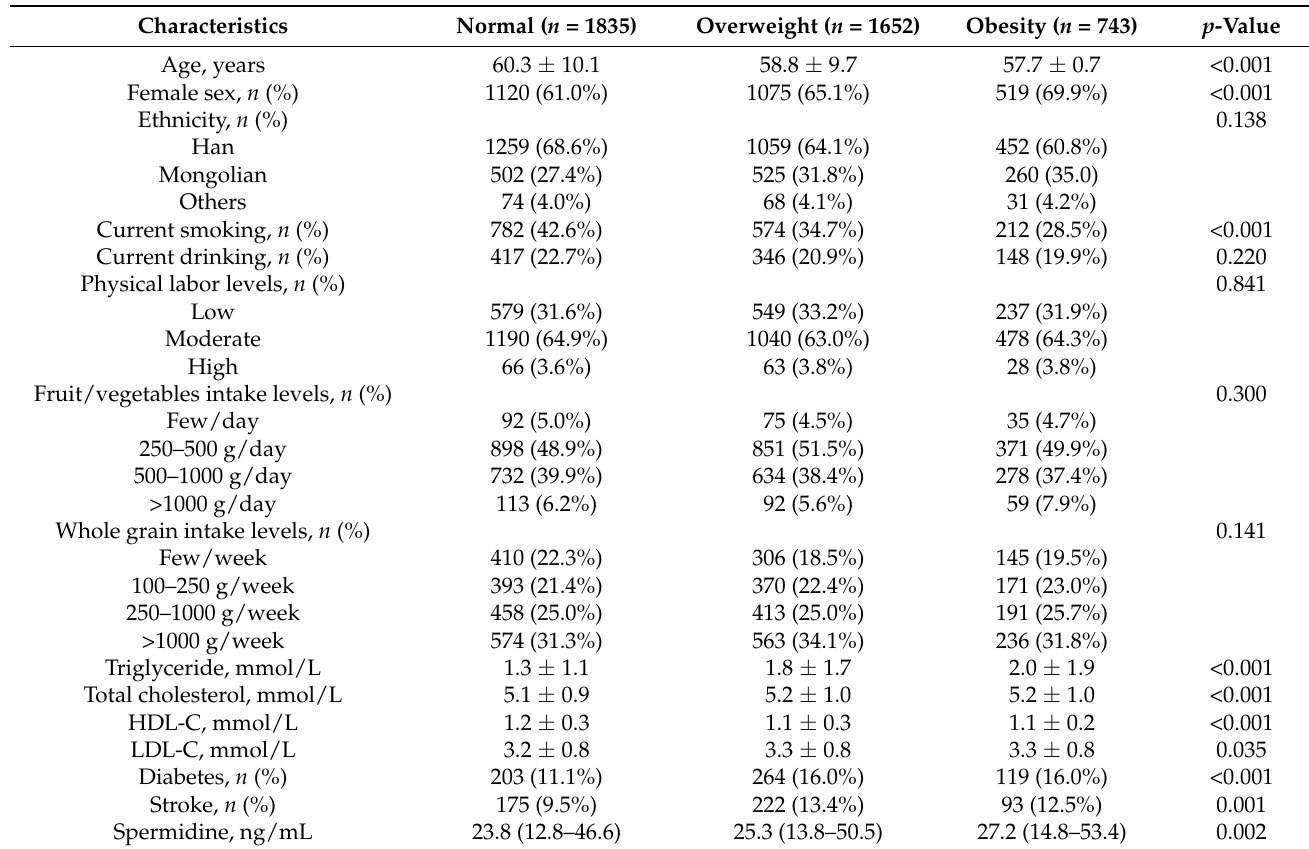
Table 1. Characteristics of participants at baseline by normal, overweight and obesity.